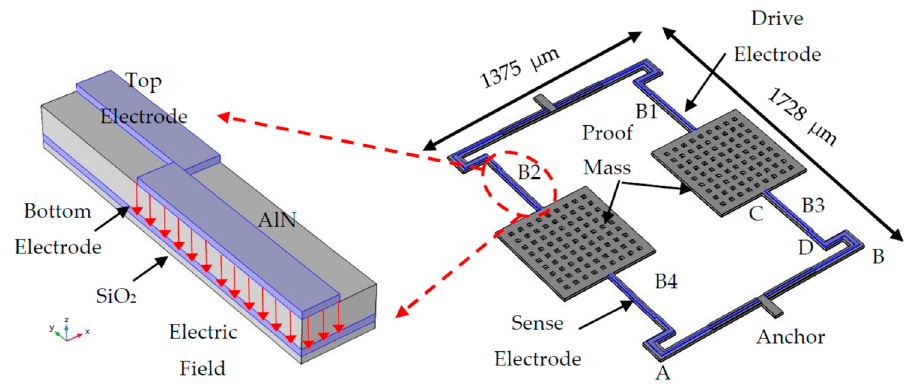
Figure 2. The structure of the aluminum nitride (AlN) MEMS accelerometer. In addition, the detailed analysis of the core beams (B1, B2, B3, B4). Table 1. The structure parameters of the AlN MEMS accelerometer.